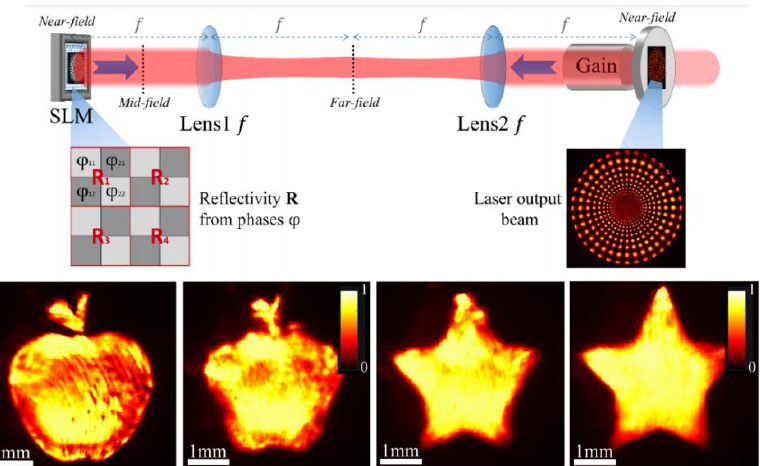
Figure 11. Schematic of the digital linear laser, apple patterns at z = 0 mm, 100 mm, 200 mm, and star patterns at z = 300 mm (Adapted from an open-access source Ref. [90]).